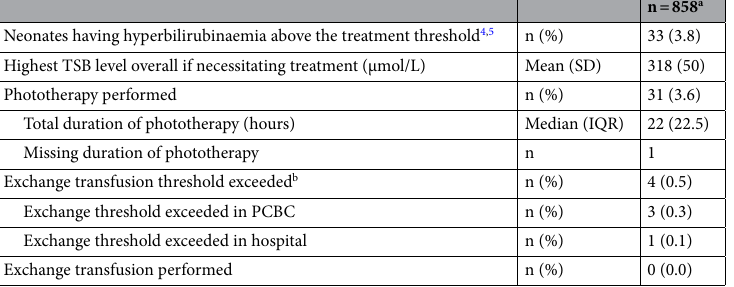
Table 3. Hyperbilirubinaemia management. SD standard deviation, IQR interquartile range. a The need for phototherapy was unknown for two neonates, as daily measurements and parental questionnaire were not filled out. These neonates were excluded from these analyses. b Phototherapy threshold according to the Dutch TSB nomogram 4,5 .